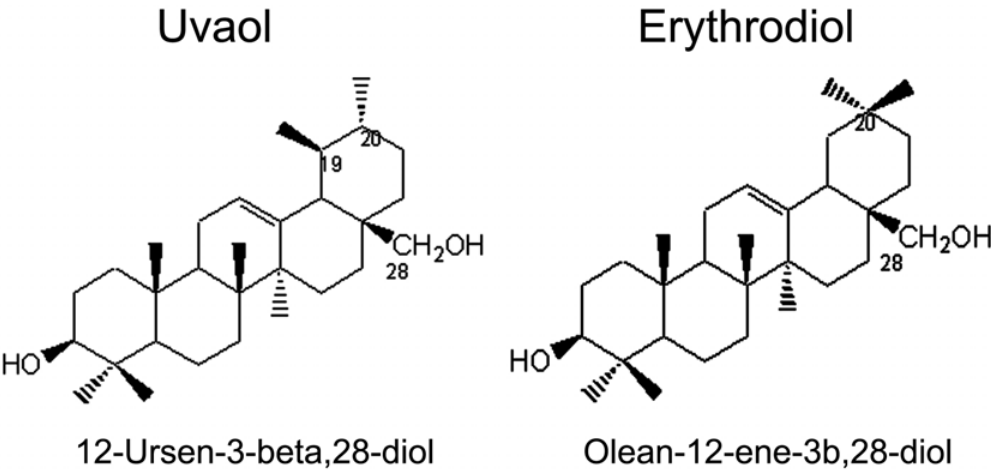
Figure 1. Molecular structure of uvaol and erythrodiol.